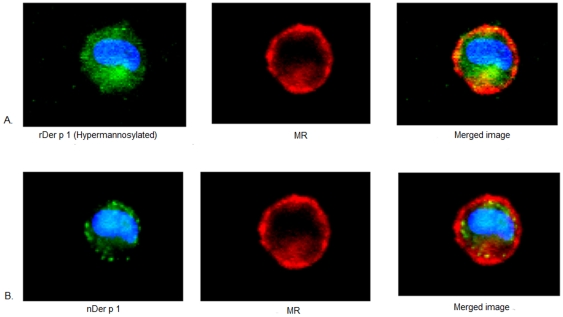
Confocal images of the difference between recombinant and natural Der p 1 (0.5 µg/ml) uptake by the same immature DC at 37°C.The results suggest that the uptake of the recombinant preparation (A) is higher than that for natural Der p 1 (B) in the same DC. A. Green: rDer p 1 labelled with FITC, red: MR labelled with PE, blue: nucleus labelled with DAPI. B. Green: nDer p 1 labelled with Cy5, red: MR labelled with PE, blue: nucleus labelled with DAPI.